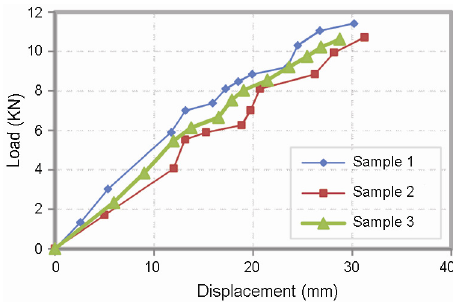
Fig. 18. Load-displacement curves for FRP-strengthened speci- mens with two layers of GFRP and with longitudinal grooves of 4 mm depth